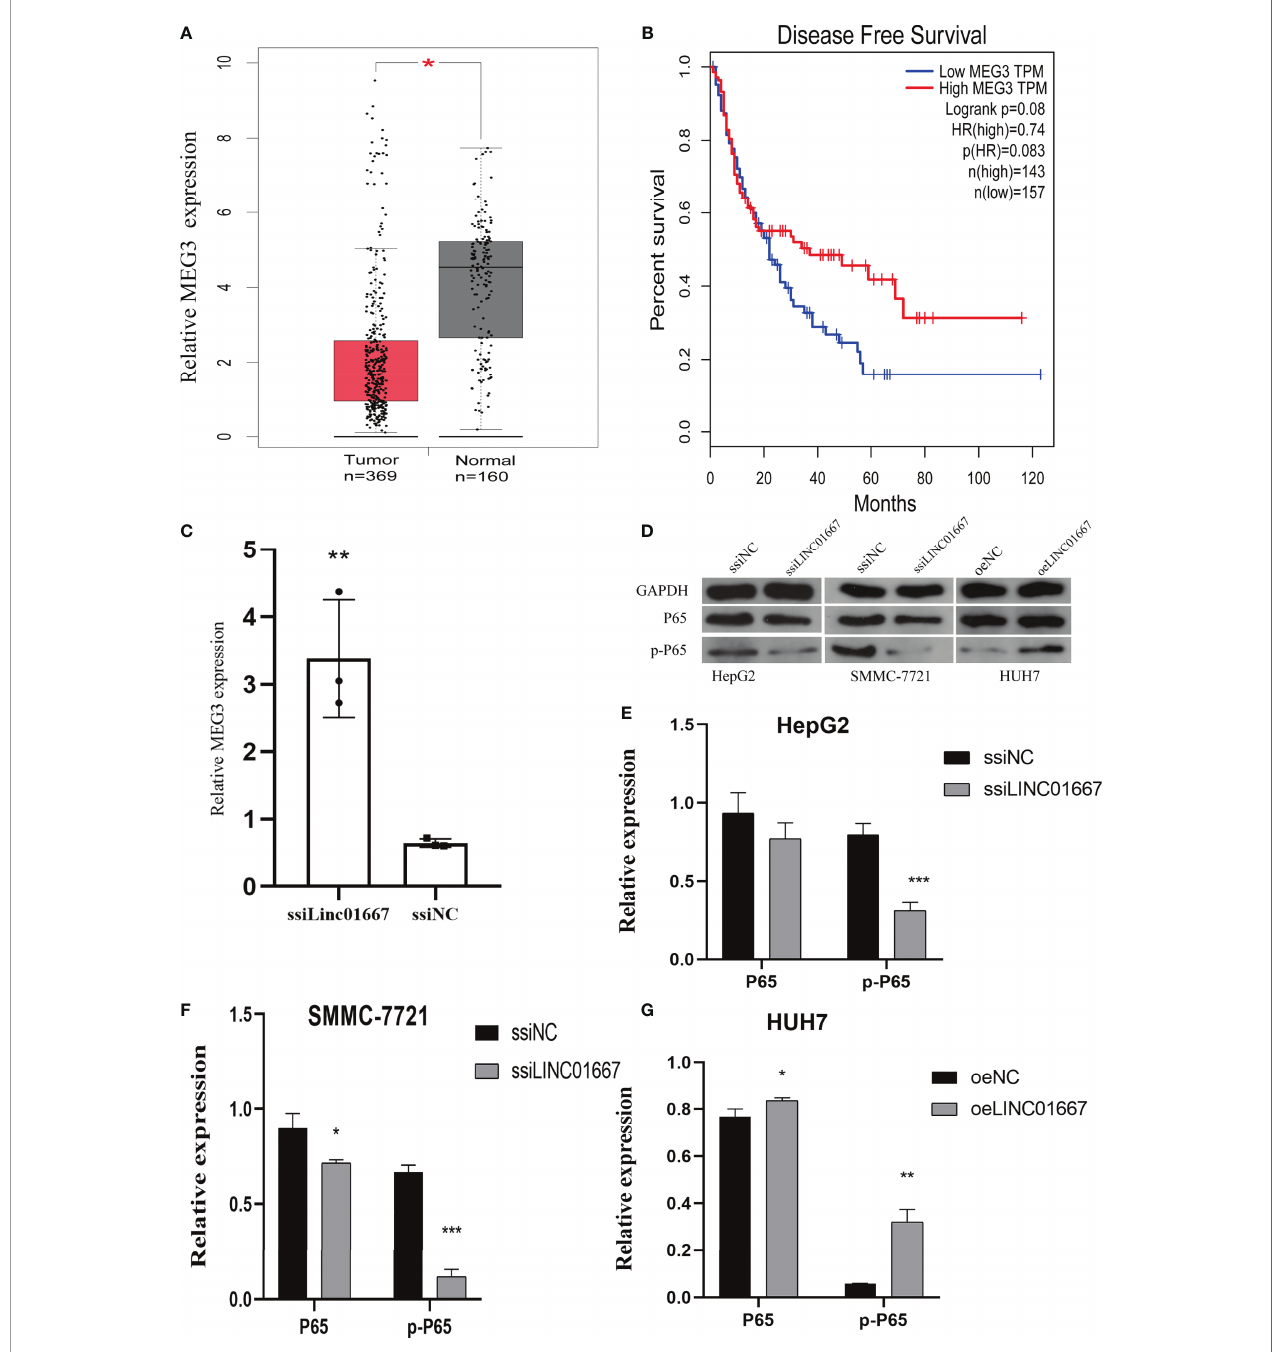
FIGURE 6 | LINC01667 has a regulatory relationship with MEG3 and NF- k B. (A) MEG3 expression levels in TCGA and GEPIA cohorts (normal = 160, tumor = 369, * P <0.05). (B) Kaplan – Meier curves showing the OS of patients with HCC according to high and low LINC01667 expression in a TCGA cohort (n = 300). (C) Knockdown of LINC01667 increases the expression of MEG3. (D – G) LINC01667 could activate the NF- k B pathway. * P < 0.05. ** P < 0.01, *** P < 0.001. oeNC represents the empty vector group, and oeLINC01667 represents the overexpression LINC01667 group, ssiNC represents the random sequence, and ssiLINC01667 represents the knockdown LINC01667